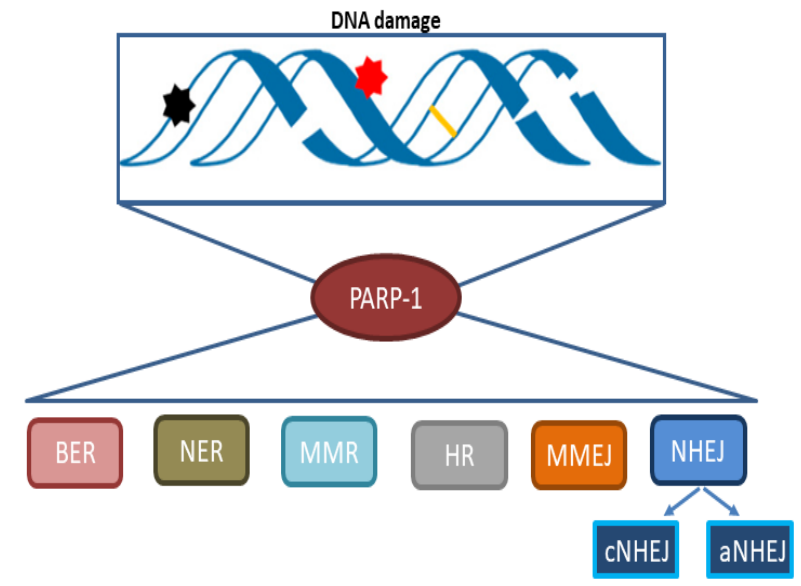
Figure 1. PARP-1 (poly(ADP-ribose)-polymerase 1) plays a role in multiple DNA damage recognition and repair pathways. BER, base excision repair; NER, nucleotide excision repair; MMR, mismatch repair; HR, homologous recombination; MMEJ, microhomology-mediated end-joining; NHEJ, non-homologous end-joining; cNHEJ, classical non-homologous end-joining; aNHEJ, alternative non-homologous end-joining.